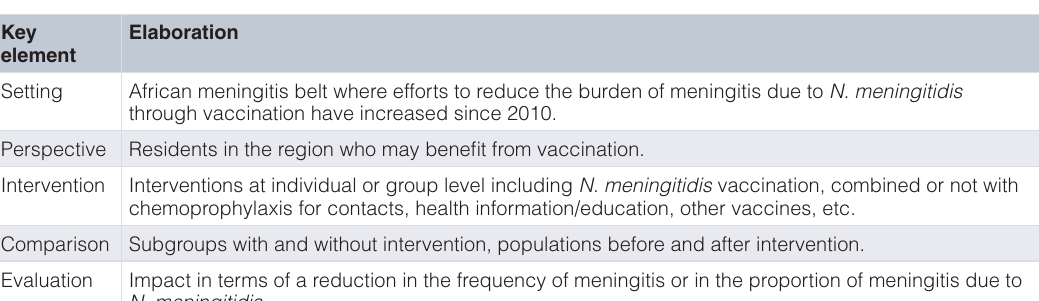
Table 1. Overview of the key elements of the review